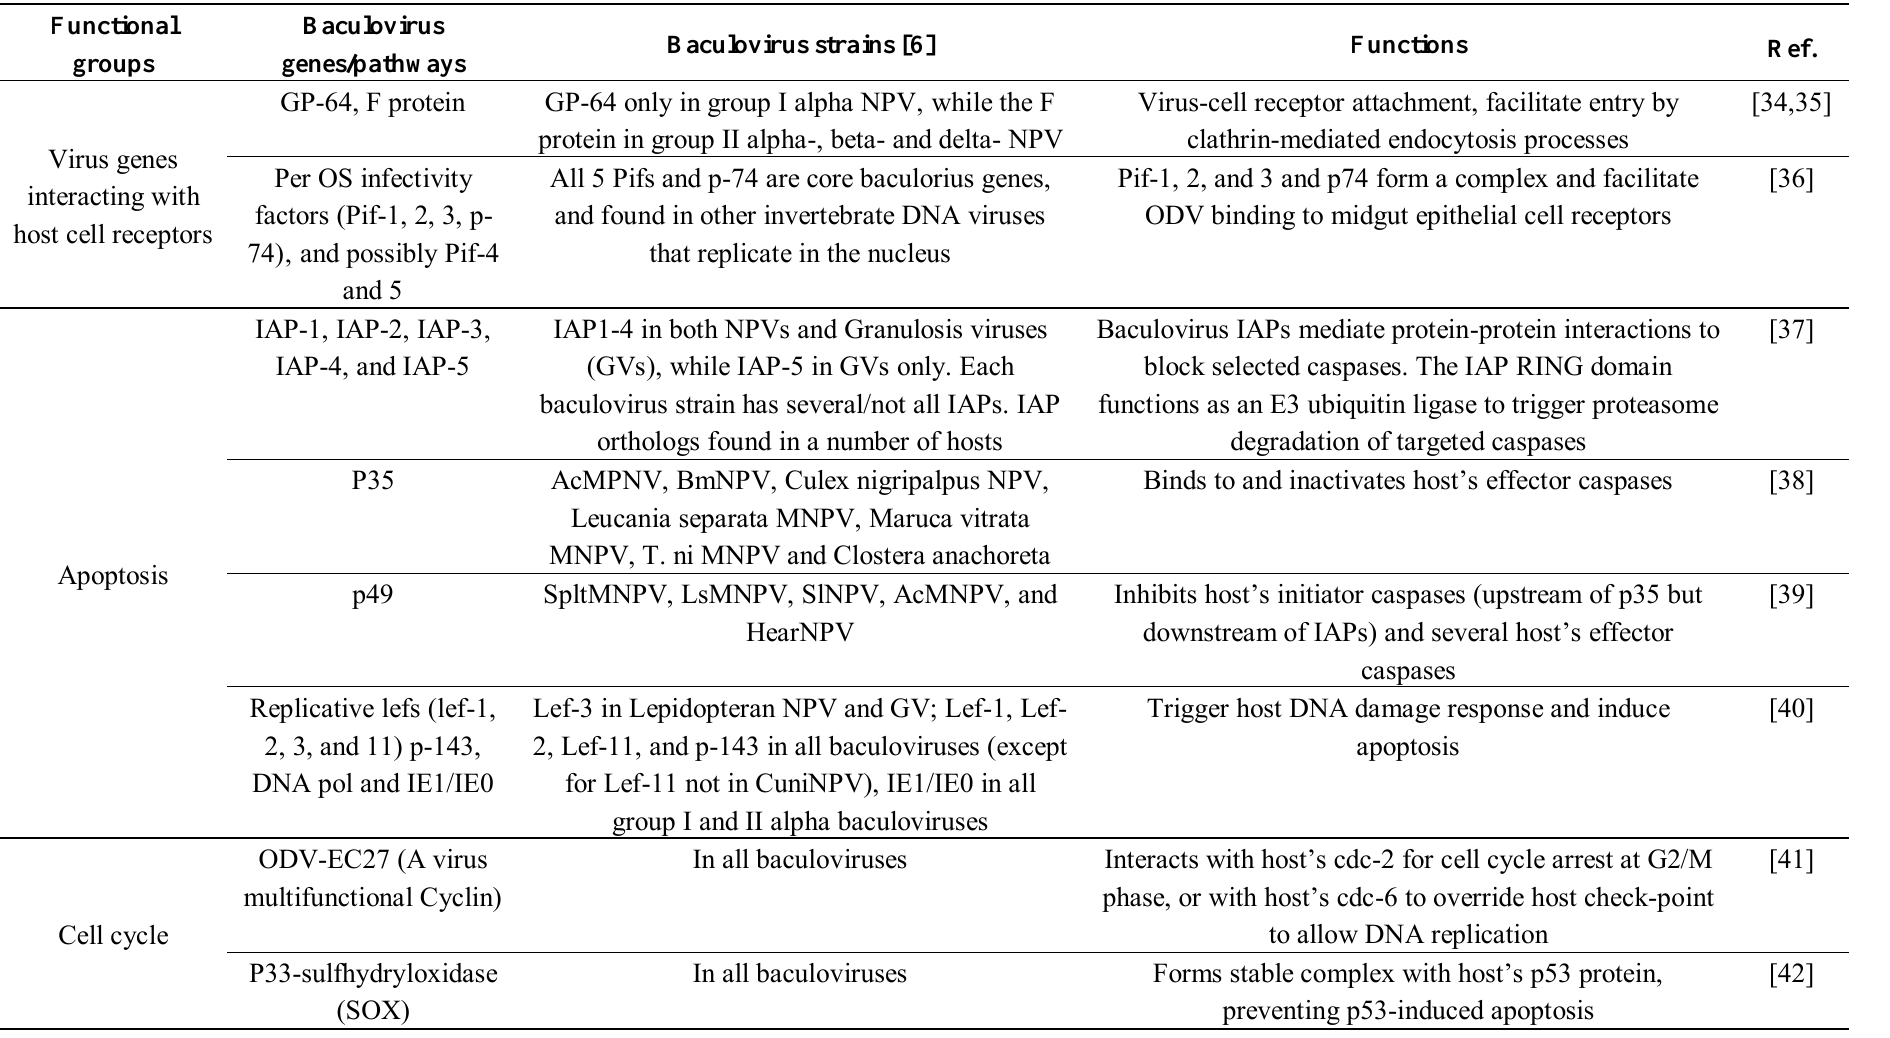
Table 1. Virus genes with known interactions with host genes or known effects on host